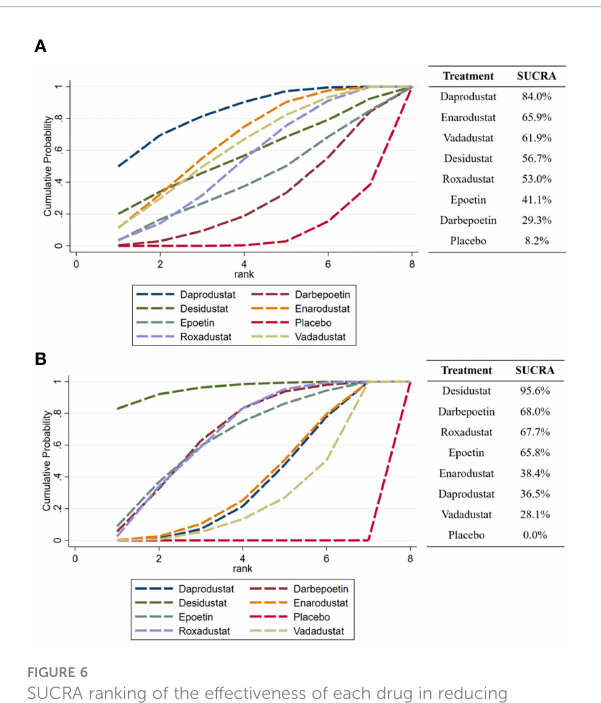
FIGURE 6 SUCRA ranking of the effectiveness of each drug in reducing hepcidin and increase Hb. (A) hepcidin, (B)